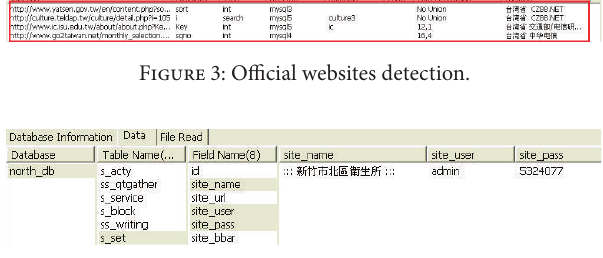
Figure 4: Official website stores database password in plain